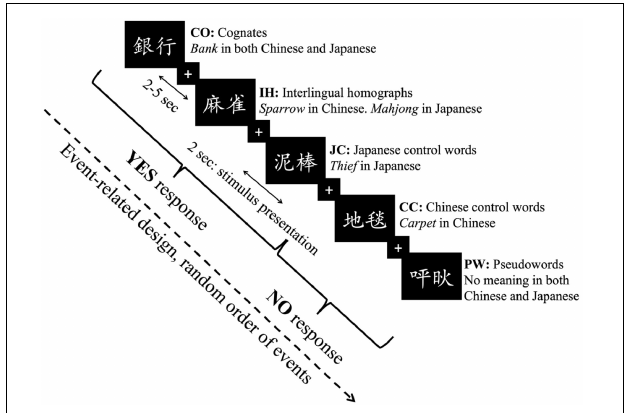
FIGURE 1 | Experimental design. Event-related design for the fMRI experiment.